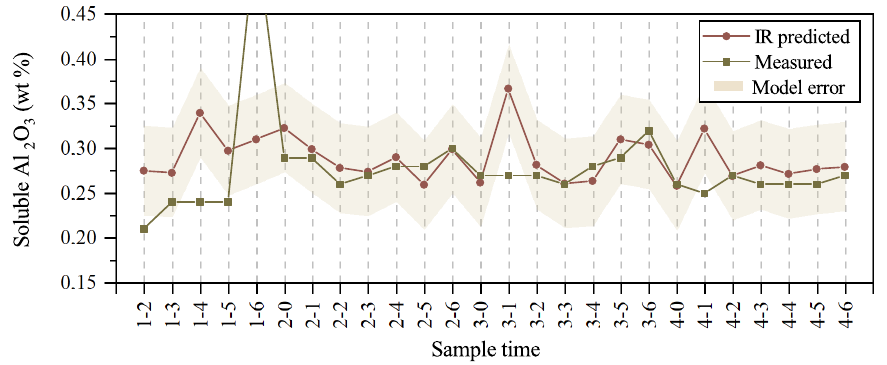
Figure 4. IR-predicted values of the validation sample set using the updated SVR calibration model, compared to the measured values. The samples are labelled as x-y, where x = sampling day and y = sampling time. Sample 1–6 (measured) not displayed for purposes of scale (measured value =